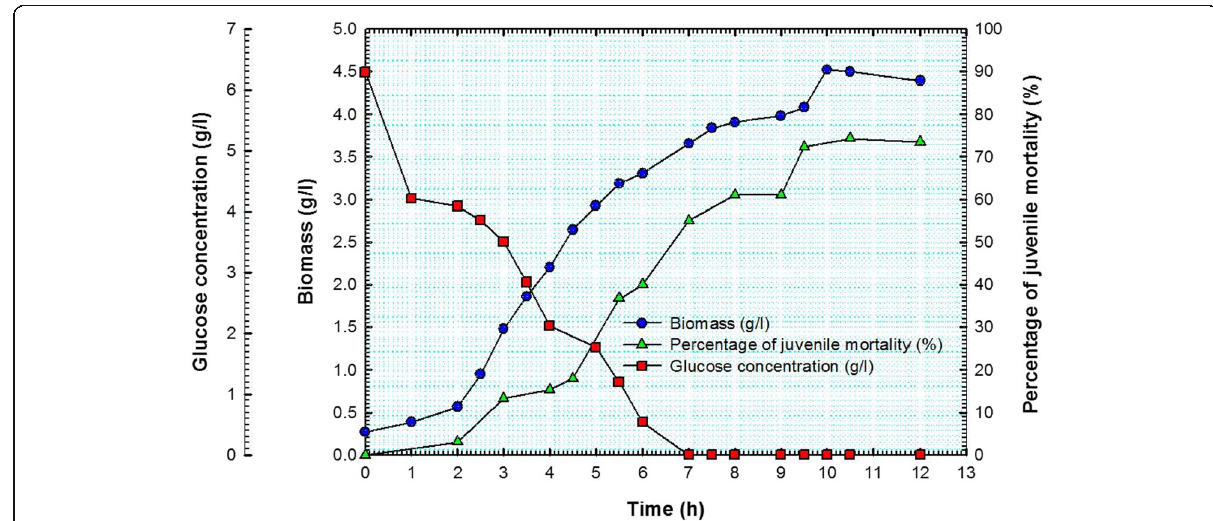
Fig. 8 Biomass, percentage of juvenile mortality at a concentration of 5%, and glucose concentration as a function of time for batch fermentation no. 2 of Bacillus subtilis isolate